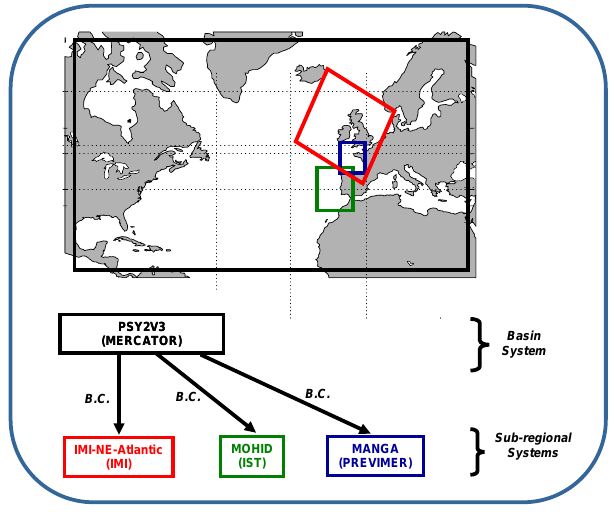
Figure 2: Downscalling scheme of integrated IBIROOS V1(B.C. = Boundary Conditions) Fig. 2. Downscalling scheme of integrated IBIROOS V1 (B.C. = Boundary